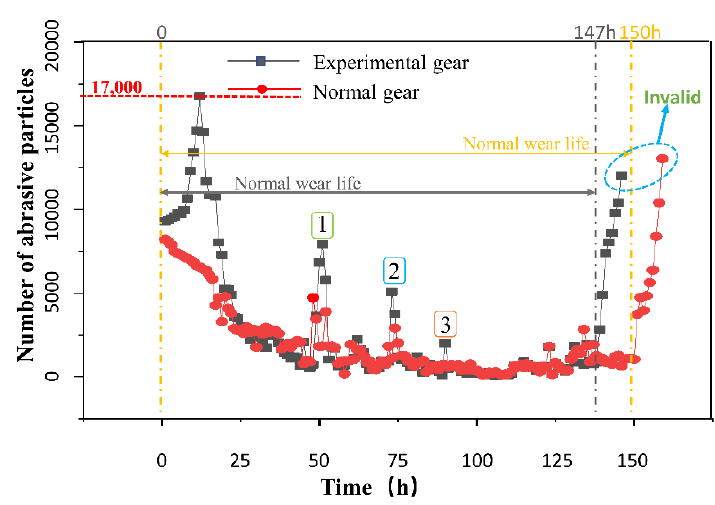
Figure 5. “ B athtub shaped” point line diagram of wear particle change. Figure 5. “Bathtub shaped” point line diagram of wear particle